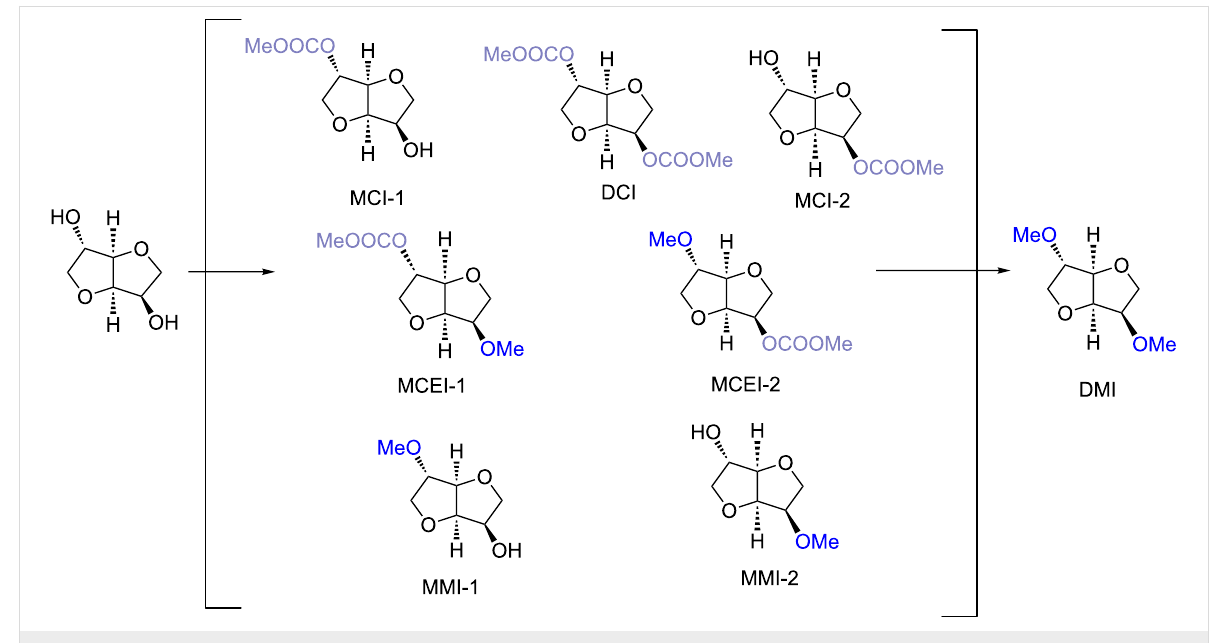
Scheme 5: Synthesis of DMI via DMC